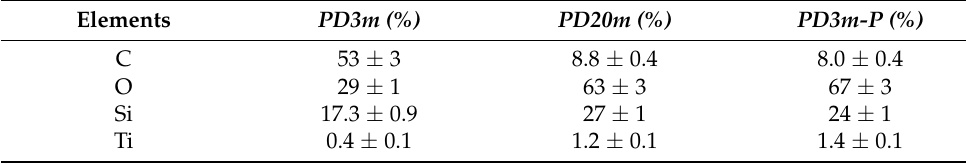
Table 2. XPS elemental compositions of PD3m , PD20m , and PD3m-P coatings.